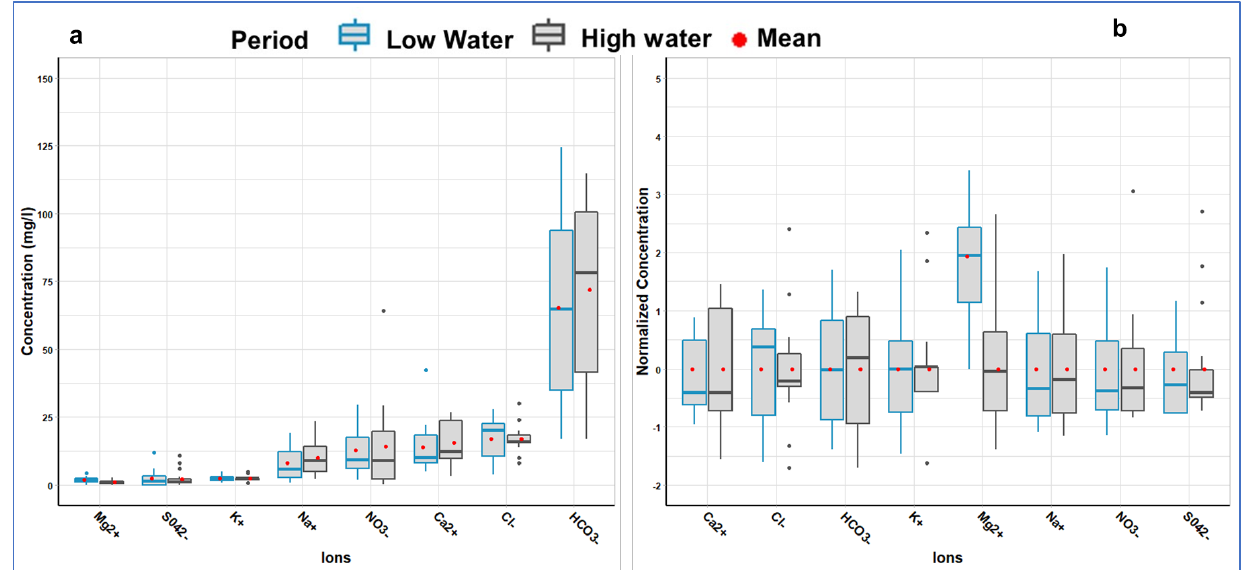
Figure 6. Plotting of statistical values of concentration of major ions of water sampled from observation wells during low- and high-water periods Sanon site: ( a ) raw concentration in mg/L and ( b ) normalized concentration.